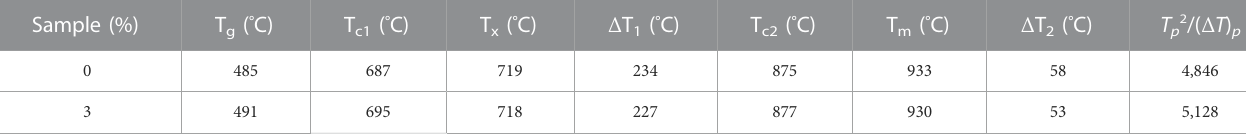
TABLE 1 DTA results of the basic glass (0%) and the glass powder doped with 3wt% whiskers (3%). Sample